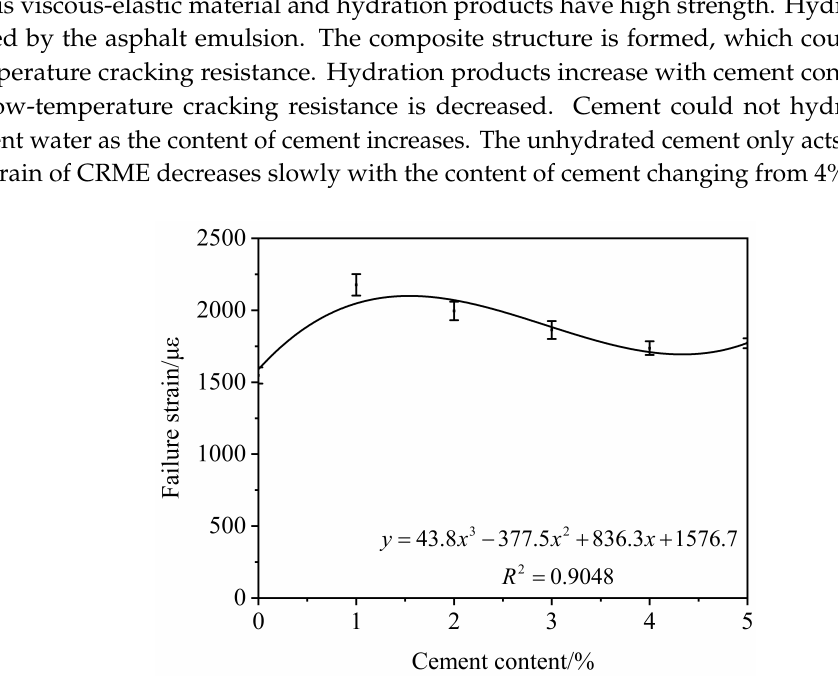
Figure 3. Results of three-point bending